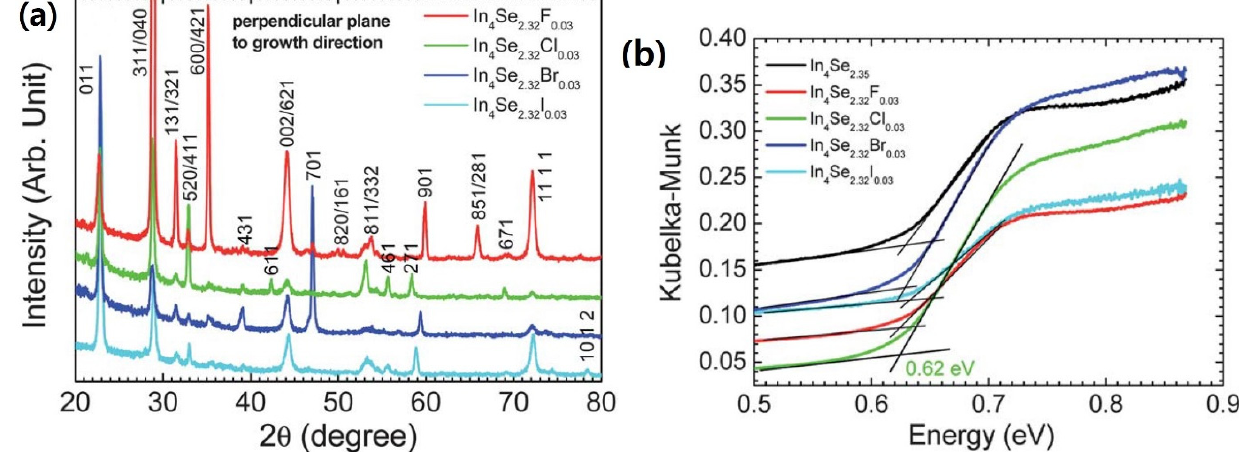
Figure 15. ( a ) The X-Ray diffraction patterns perpendicular planes to the crystal growth direction and ( b ) Infrared absorption spectra and of the crystals of In 4 Se 3 − x H 0.03 ( x = 0.68; H = F, Cl, Br, I) and In 4 Se 2.35